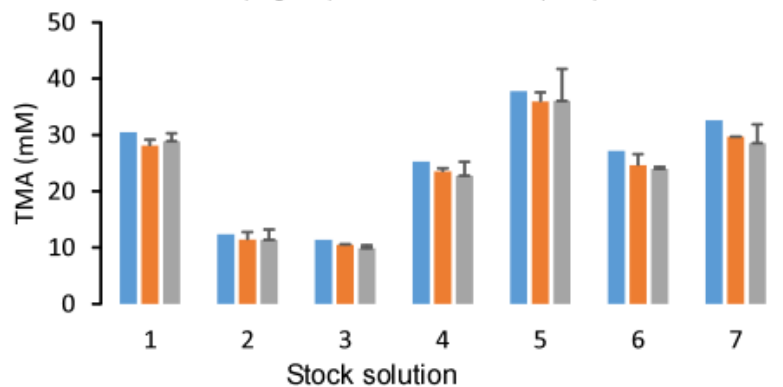
Figure 8. Stability of the TMA stock solution during storage at room temperature. Varying concentrations of TMA standards in sterile water were stored in glass vials and kept at room temperature. The concentrations after 2 and 3 months of storage were measured by LC / MS / MS. Each stock solution was diluted to 10–50 µ M and calibrated with standard curves after spiking-in a fixed amount of d9-TMA as an internal standard. Data were presented as mean ± SD from three replicates.